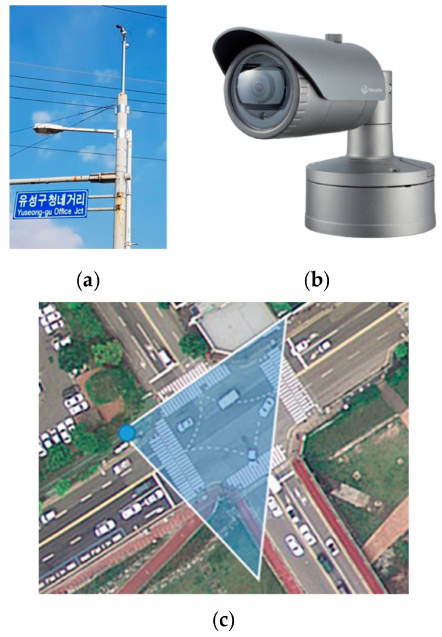
Figure 1. Camera location and installation in the study area: ( a ) installation of the camera; ( b ) XNO-6010R sensor; and ( c ) location and coverage of the camera at an